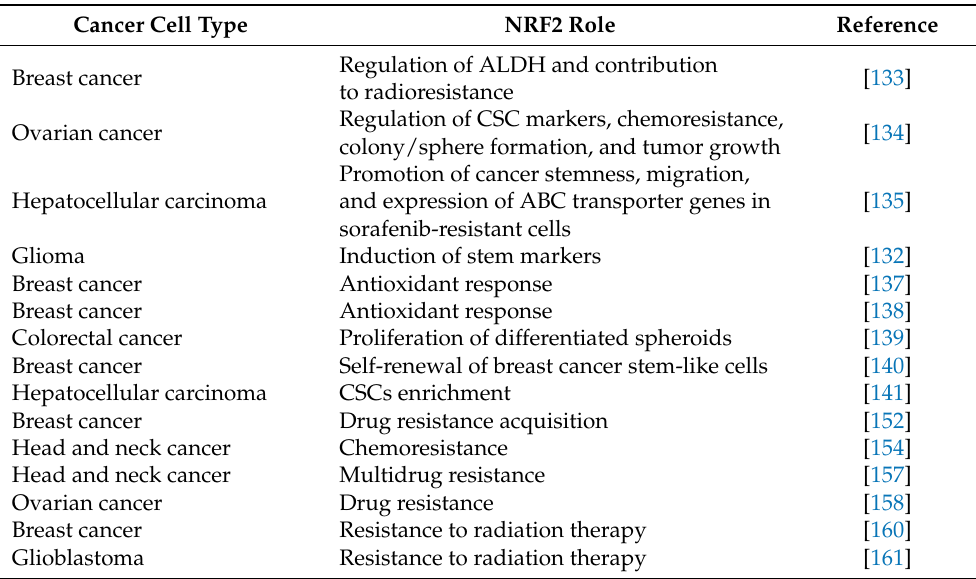
Table 3. The role of NRF2 in different cancer stem cell models. Cancer Cell